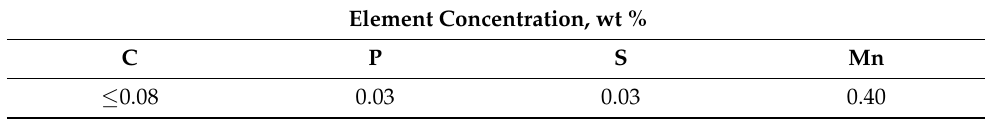
Table 1. Chemical composition of the DC04 steel.